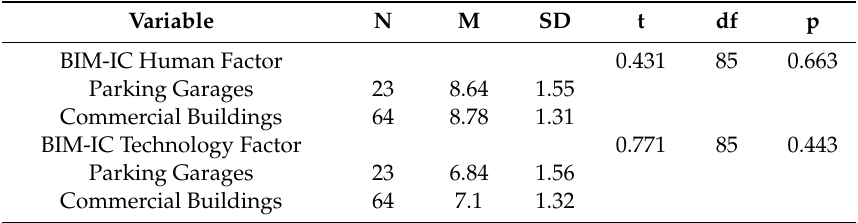
Table 4. BIM-IC: Human and Technology Factor by Building Type